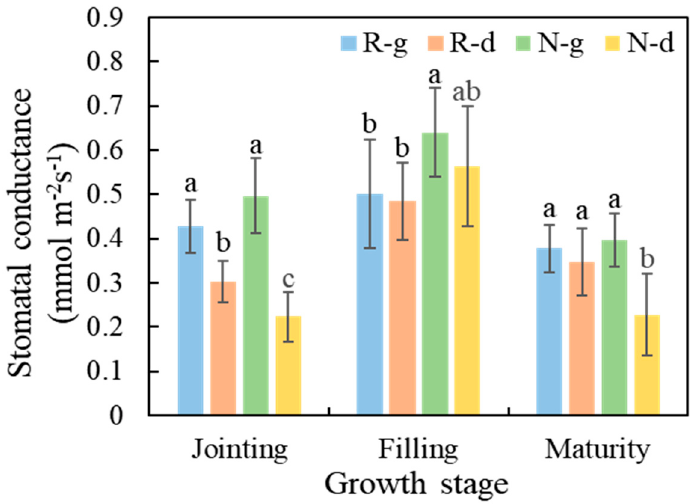
Figure 2. Effects of warming and drought stress on stomatal conductance of winter wheat. Each data point indicates the average value of three replicates. The lowercase letters indicate significant differences ( p <